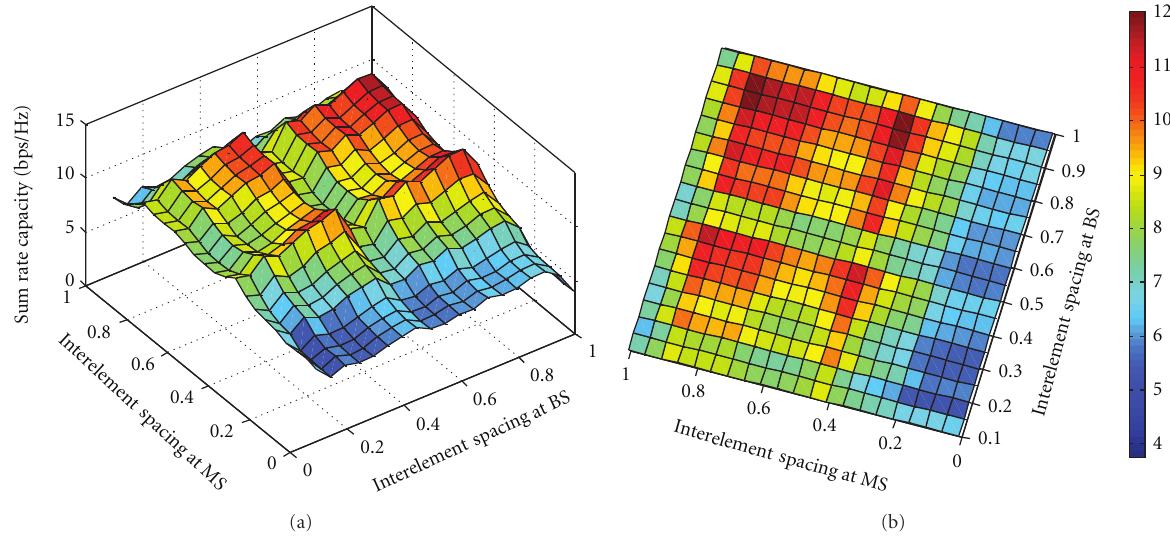
Figure 7: Surface of sum rate capacity with transmit and receive spatial correlation only for a 2 × (3 × 6) multiuser MIMO system at SNR = 20dB.